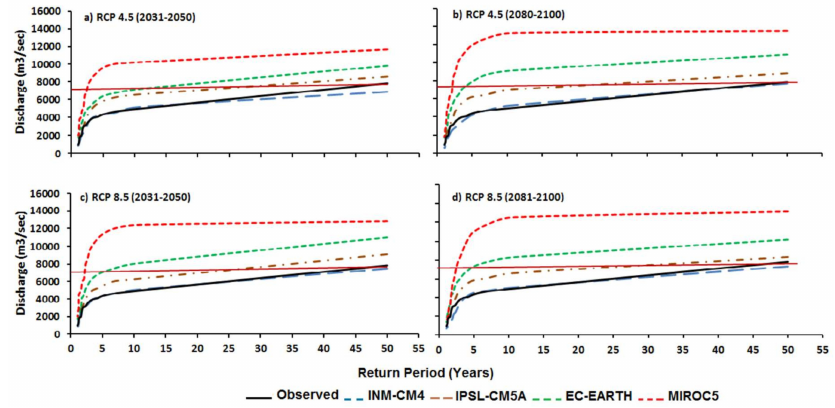
Figure 7. Return periods of peak flow in Kabul river (years). Results for four different GCMs for the RCPs 4.5 and 8.5 for the near future (2031–2050, ( a , c )) and far future (2081–2100, ( b , d )) are presented. The horizontal dark brown line shows the magnitude of the most devastating flood in